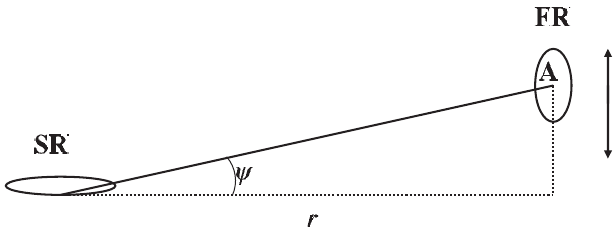
FIG. 2. Geometry for measuring the angular distribution of synchrotron radiation using a filter radiometer with an active area of A. r is the distance from the tangent point to the filter radiometer and is the off-orbital-plane angle extended by a fixed point in the active area of the filter radiometer to the tangent point.